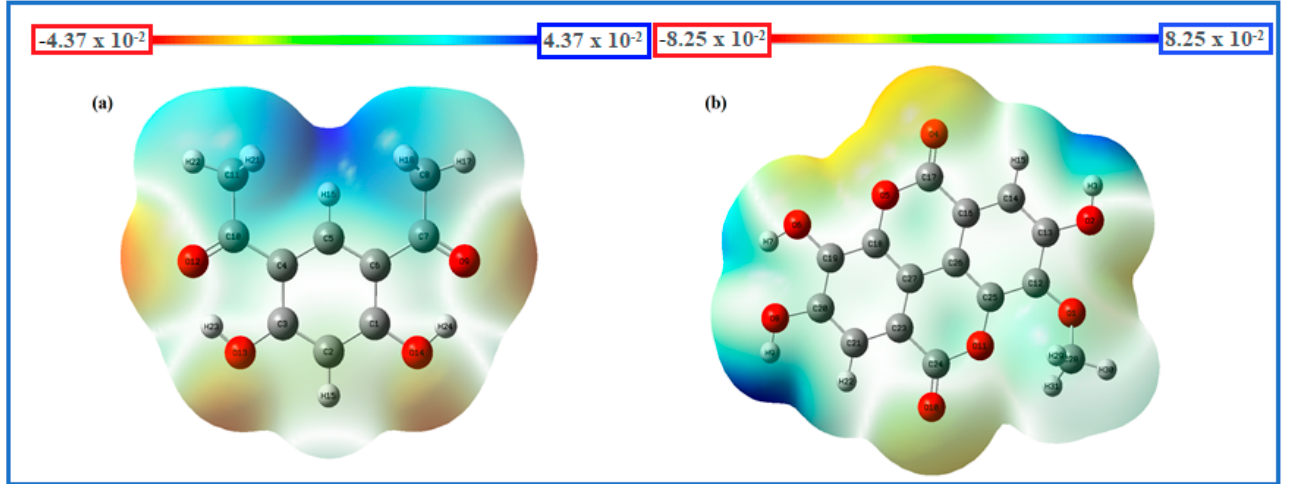
Figure 13. Molecular electrostatic potential surface of the compound 1 ( a ) and compound 2 ( b ) having regions rich and poor in electrons, as indicated by the colors red and